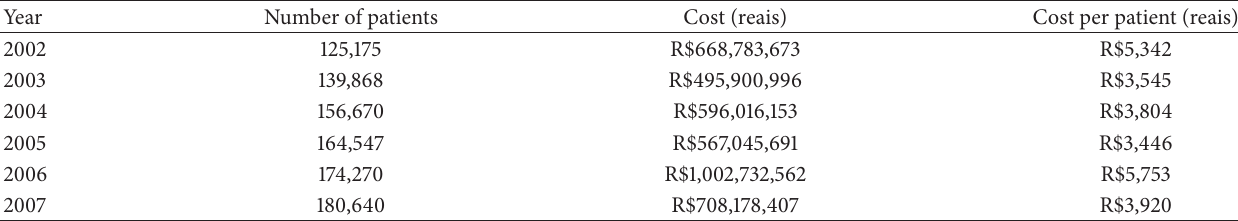
Table 1: Number of patients covered in the HIV/AIDS Program (antiretroviral drugs) and their related costs in the Brazilian Unified Health System